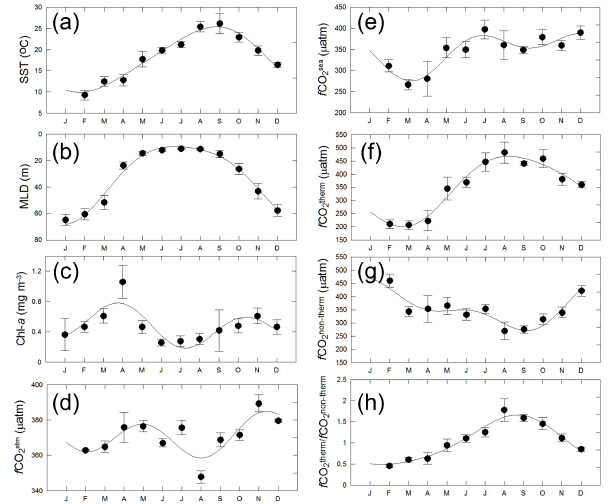
Fig. 5. Monthly variations in the (a) sea surface temperature (SST), (b) mixed layer depth (MLD), (c) chlorophyll a in the surface water, (d) f CO atm , (e) f CO sea , (f) f CO therm , (g) 2 2 2 f CO non − therm , and (h) ratio of the thermal to non-thermal effects 2 ) in the UB. The MLD was based on the ( f CO therm / f CO non − therm 2 2 climatology by de Boyer-Montégut et al. (2004). The chlorophyll a was based on the SeaWiFS data between 1998 and